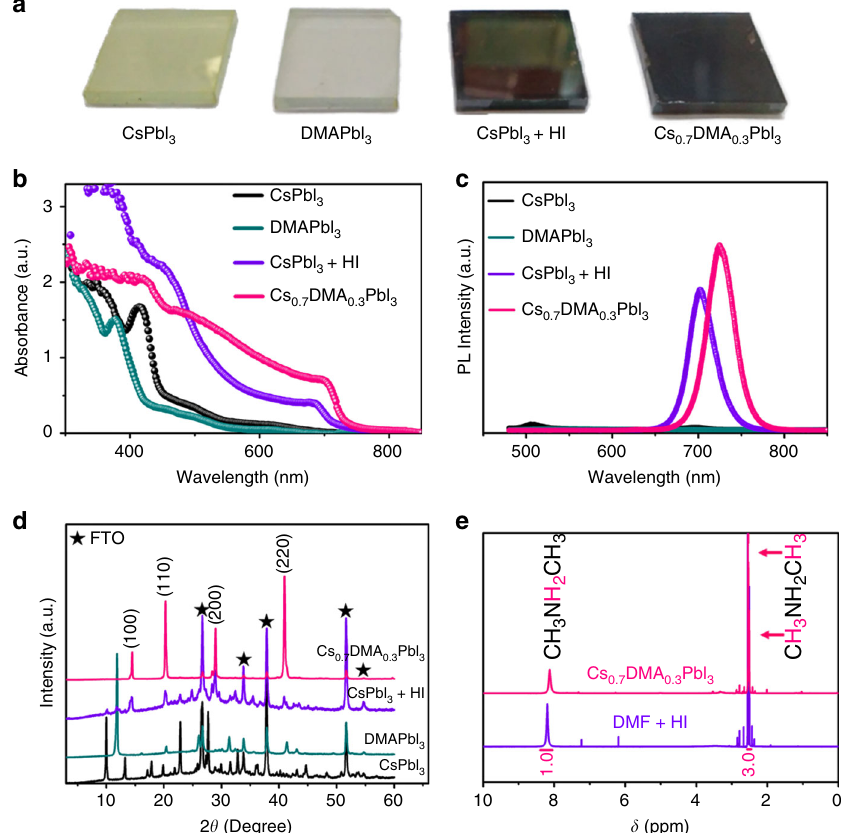
Fig. 2 Film properties and component studies. a Photographs, b UV-vis absorption spectra, c PL spectra, and d XRD patterns of a pure CsPbI 3 fi lm, a pure DMAPbI 3 fi lm, a HI-treated CsPbI 3 fi lm, and a Cs 0.7 DMA 0.3 PbI 3 fi lm. e NMR spectra of the powder obtained from scratching away Cs 0.7 DMA 0.3 PbI 3 fi lms and DMAI polycrystalline powder synthesized from DMF and HI, which were dissolved in DMSO-d